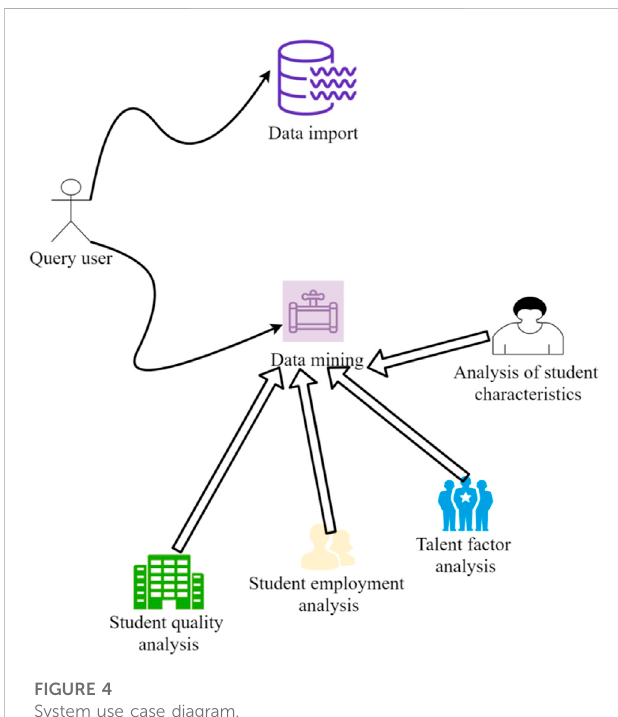
FIGURE 4 System use case